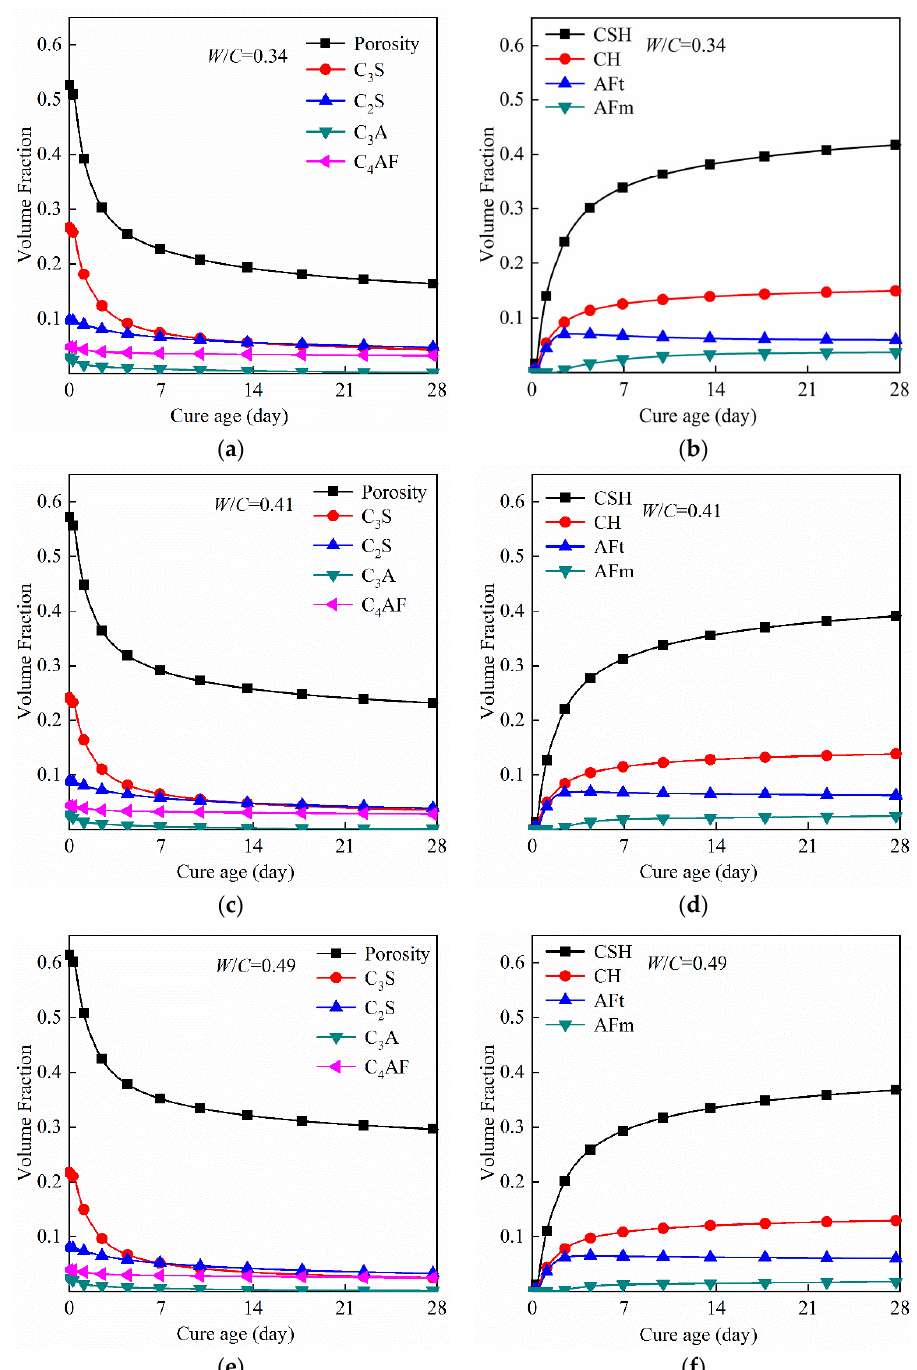
Figure 6. The simulated development of volume fraction of each phase in the cement paste during the hydration period: ( a ) and ( b ) W / C = 0.34, ( c ) and ( d ) W / C = 0.41, ( e ) and ( f ) W / C = 0.49.